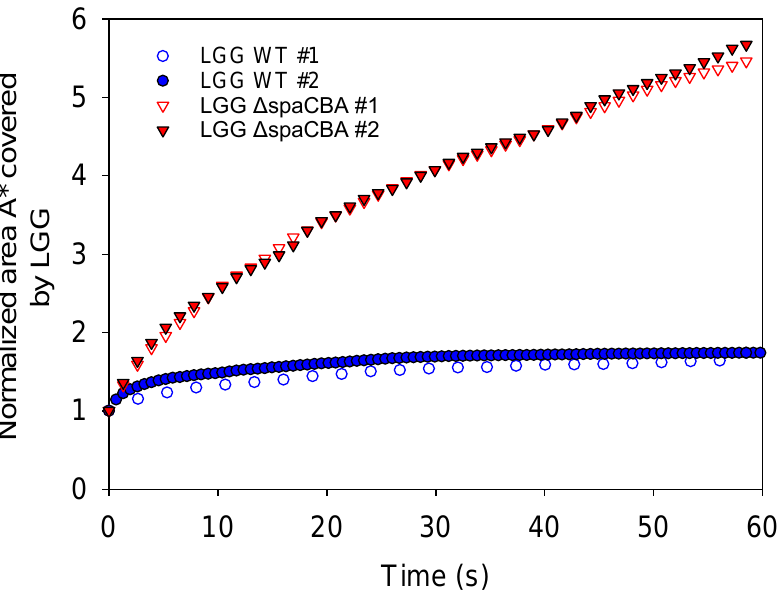
Figure 4. Normalized area ( A * ) covered by LGG for 60 s obtained from analysis of CLSM image sequences. Data were obtained in two independent samples with different acquisition frequencies.